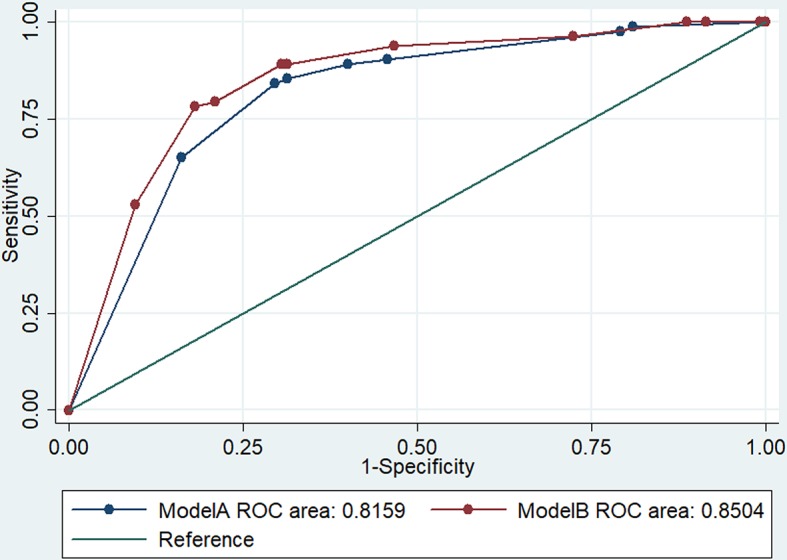
ROC analysis for both model A and model B.